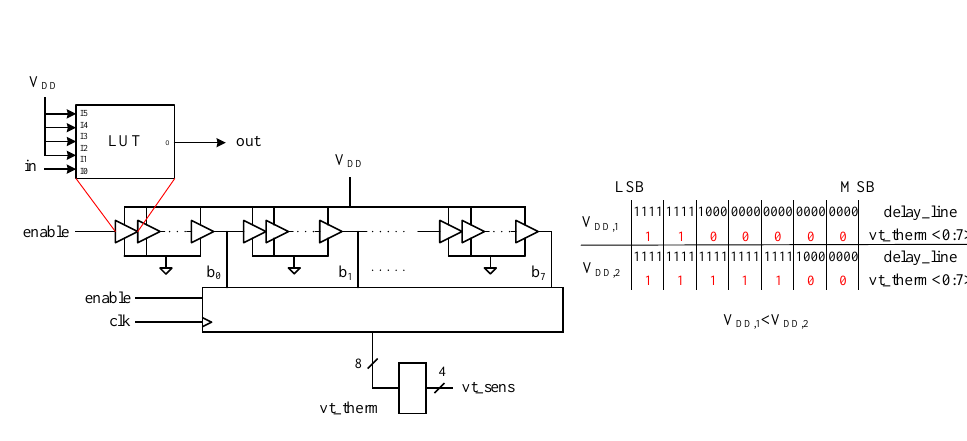
Figure 5: On-chip FPGA voltage